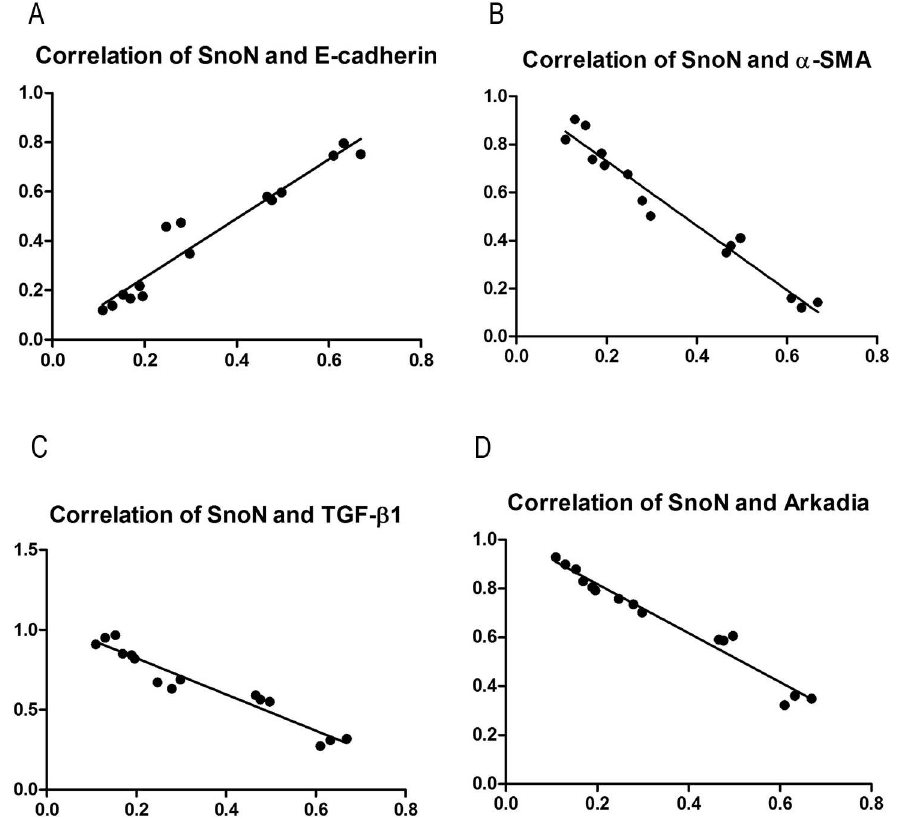
Fig 4. Associations of SnoN with DN related factors. A, The expressionof SnoN showedsignificant positive correlationwith E-cadherinlevel (r = 0.733, P < 0.01); B, C, D, The expressionof SnoN showed significantnegativecorrelationswith α -SMA, TGF- β 1, and Arkadia amounts (r = -0.873, P < 0.01;r = -0.769, P < 0.01,r = -0.705, P < 0.01,